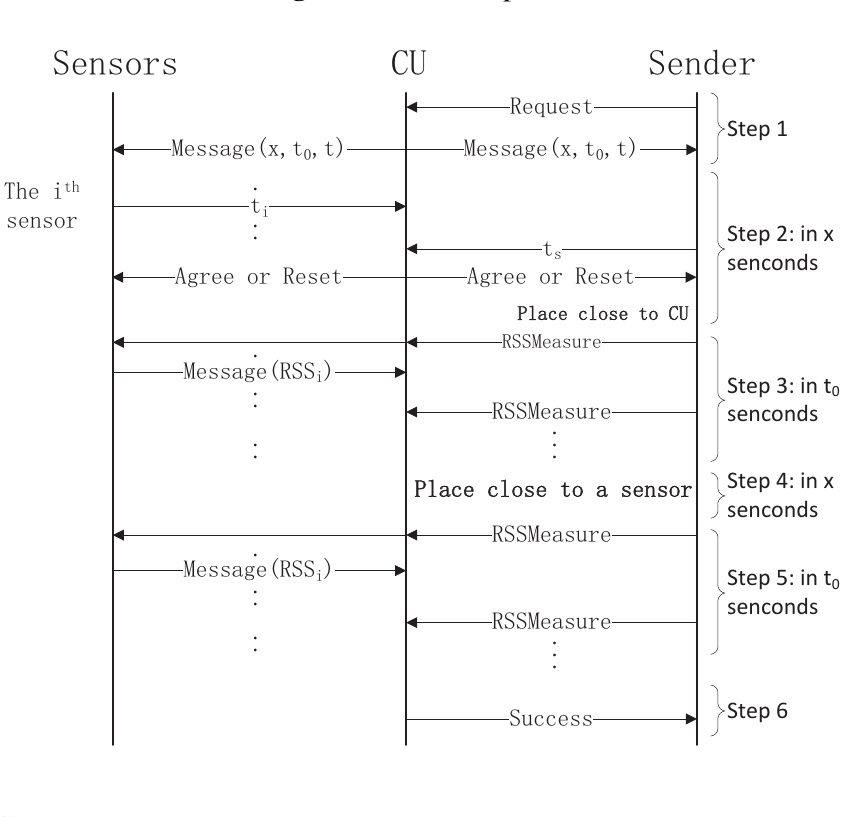
Figure 5. The final